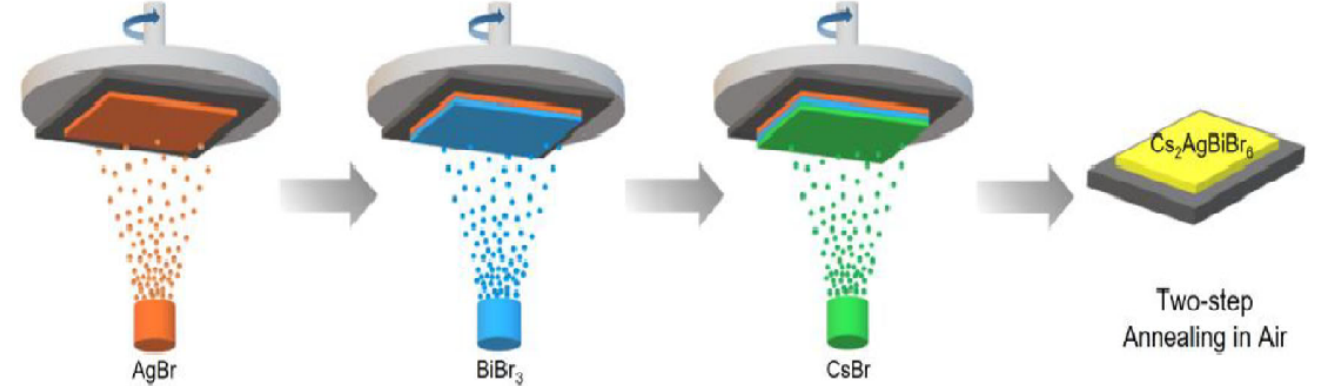
Figure 13. Scheme of sequential vapor deposition processing. Reproduced with permission from [82] . Copyright 2018, Wiley-VCH.